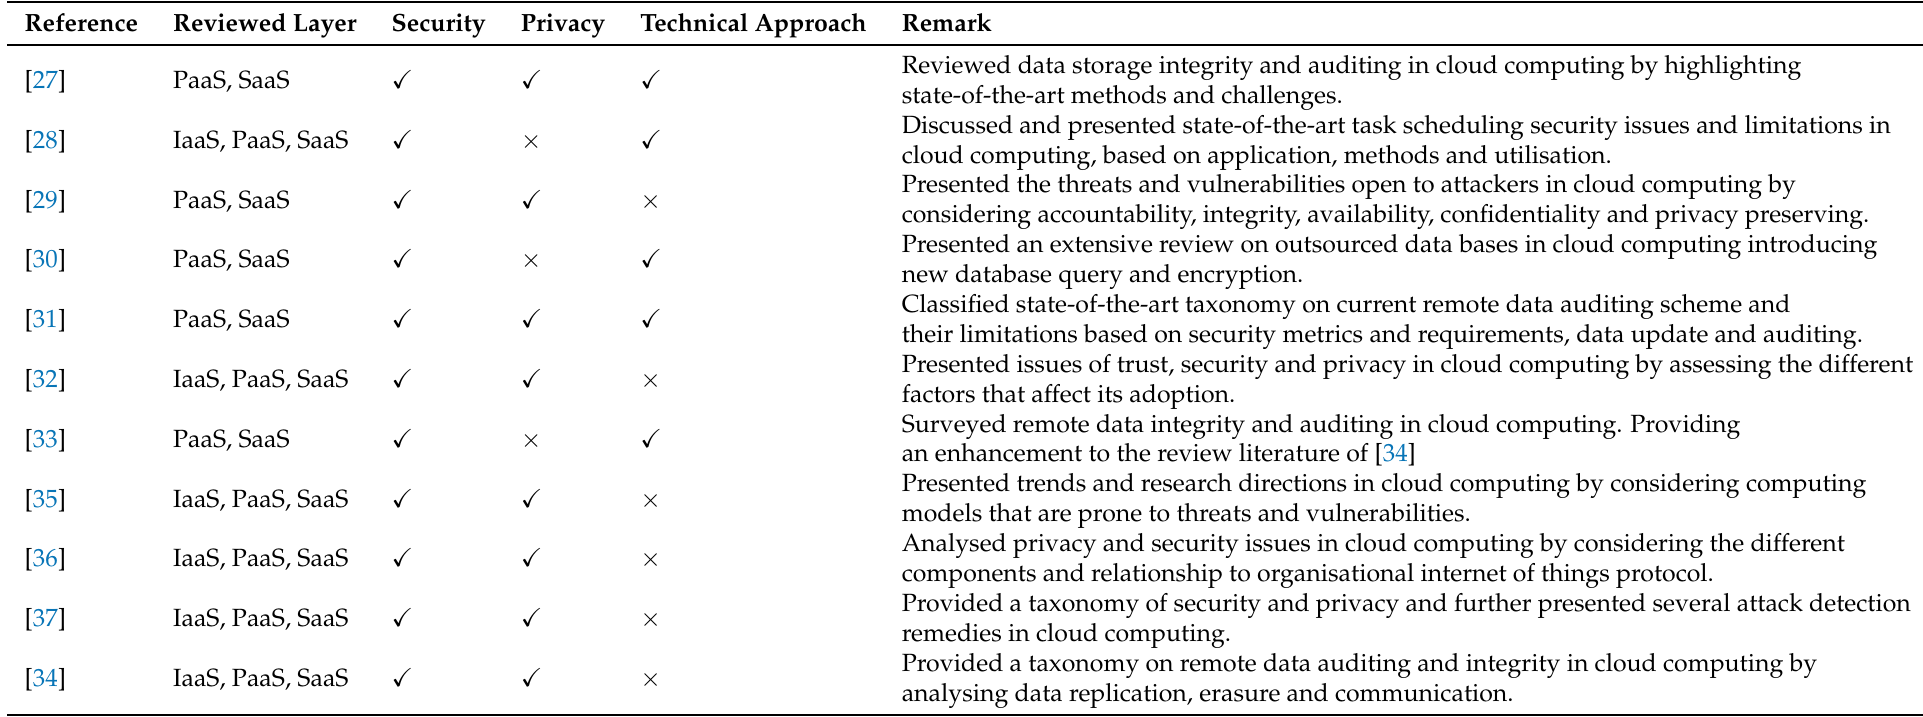
Table 4. Review of literature